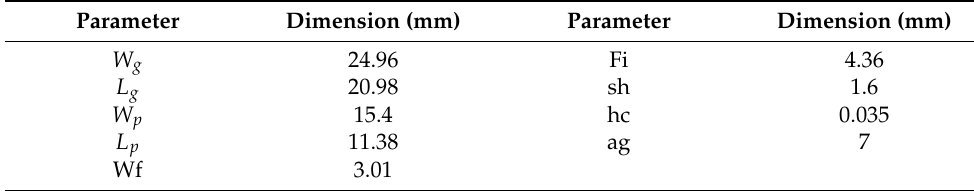
Figure 3. Rectangular MPA: ( a ) top view ( b ) side view ( c ) fabricated top and back view. The geometric parameters of the rectangular MPA, such as width and length, are calculated by using the transmission line model equations which can be found in [35,36]. The size of the ground plane and patch of the antenna are 0.50 λ 0 × 0.42 λ 0 and 0.31 λ 0 × 0.23 λ 0 , respectively ( λ 0 = free space wavelength). The rectangular MPA configuration and simulation are done using the finite integration technique-based electromagnetic CST simulator. The dimensions of the rectangular MPA are presented in Table 2. Table 2. Dimensional parameters of the rectangular MPA.